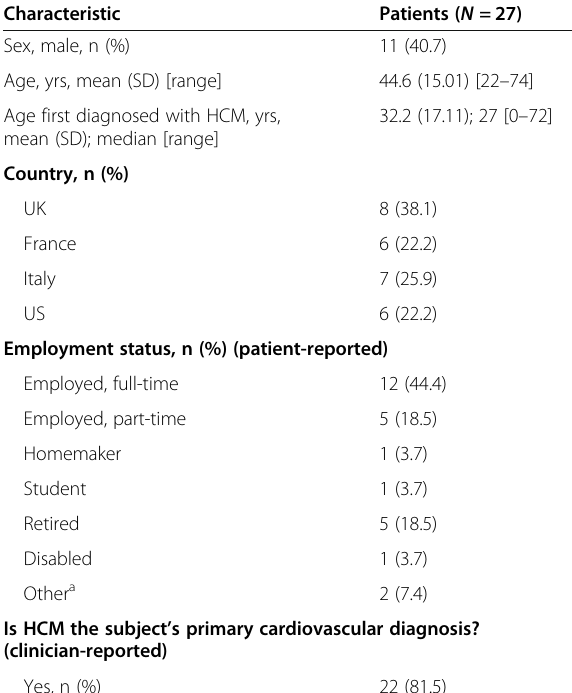
Table 2 Demographic and clinical characteristics of concept